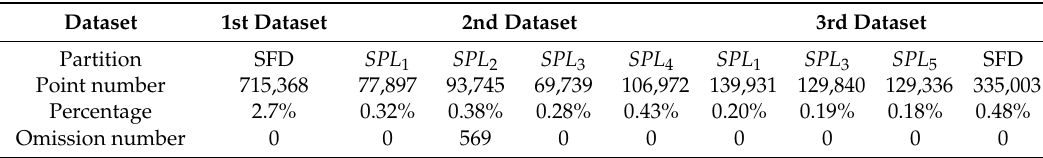
Table 5. The statistics results of point clouds in different partitions for three